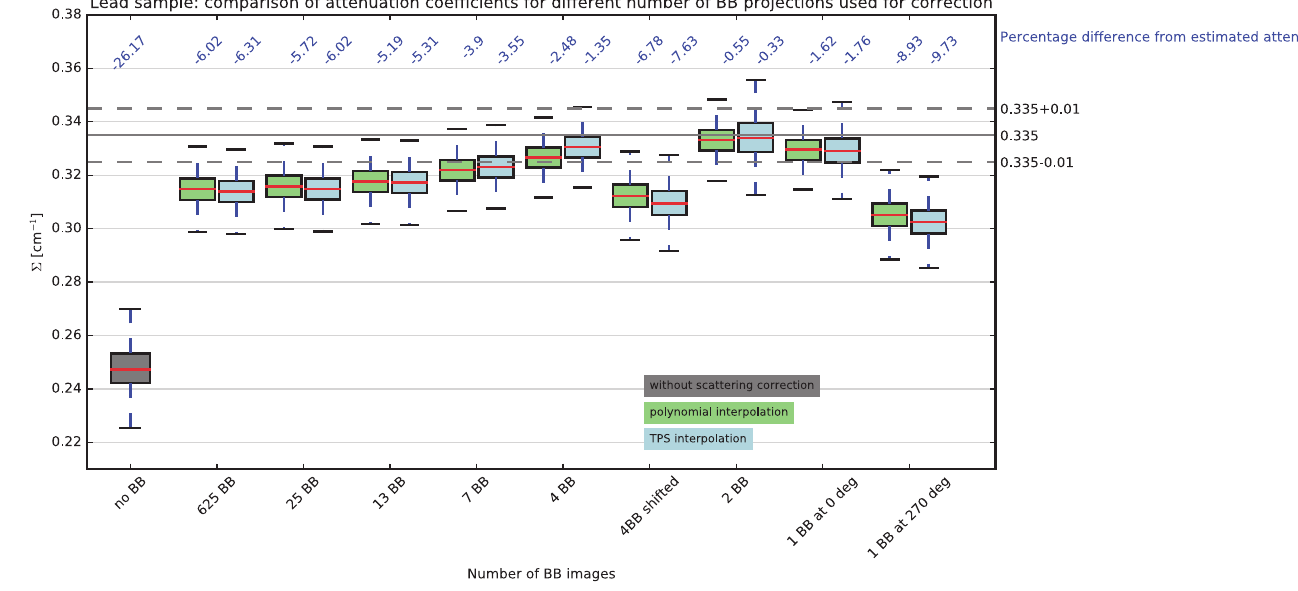
PLOS ONE | https://doi.org/10.1371/journal.pone.0210300 January 4,